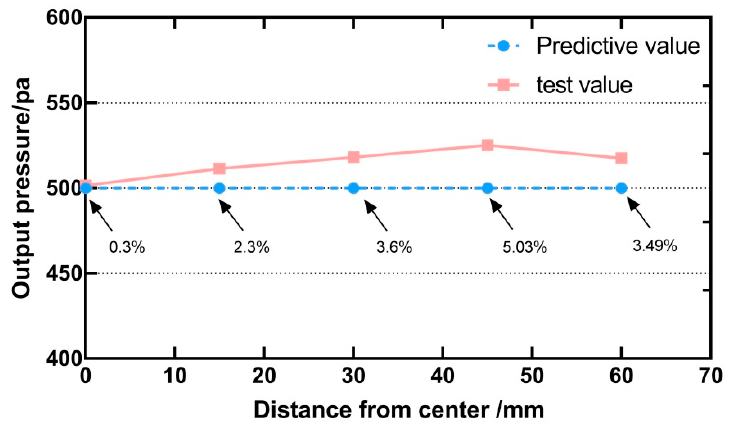
Figure 13. The predicted and measured values at different positions from the centre point on the horizontal plane. The value indicated by the arrow is the relative